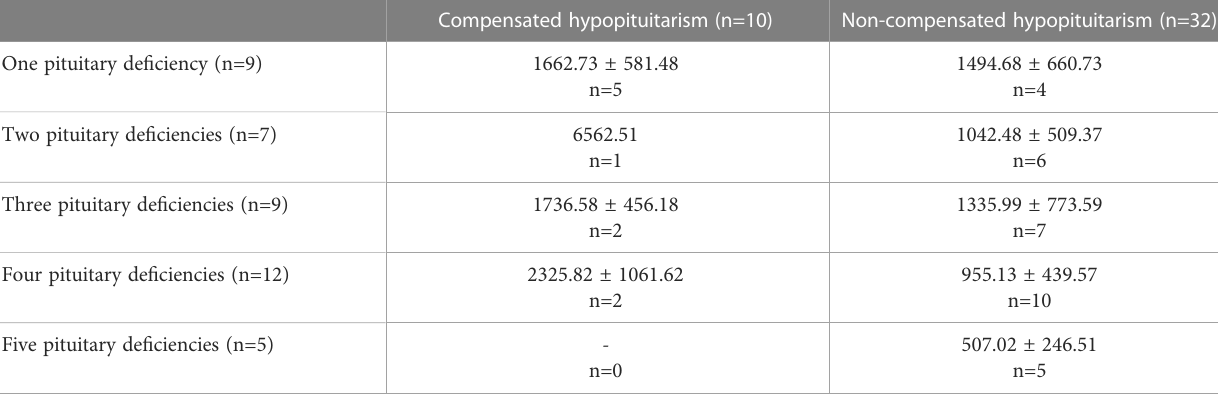
TABLE 2 Mean (± SEM) values of mannan-binding lectin (MBL) level in patients with hypopituitarism (n=42) who are on appropriate replacement therapies (compensated hypopituitarism, n=10) vs. inadequate replacement therapies (non-compensated hypopituitarism, n=32) presented in particular subgroups of individuals depending on how many pituitary axes are